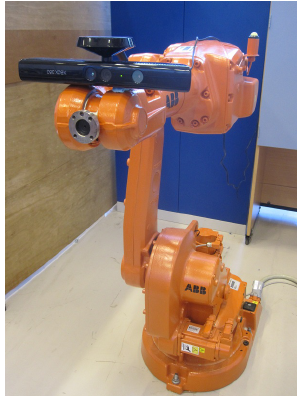
Figure 1: ABB IRB1600-1.45 robot with Microsoft Kinect sensor mounted on the 4th link.